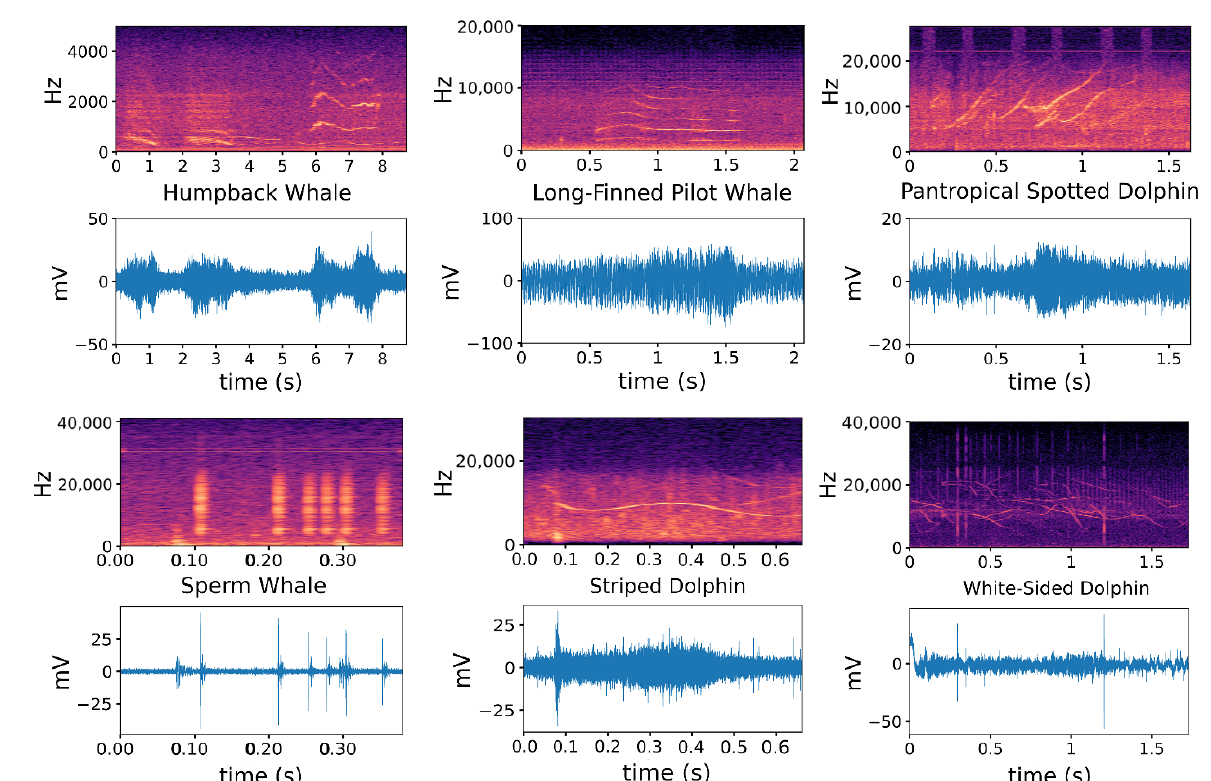
Figure 3. Comparison of acoustic signals from different species of marine mammals in time and frequency